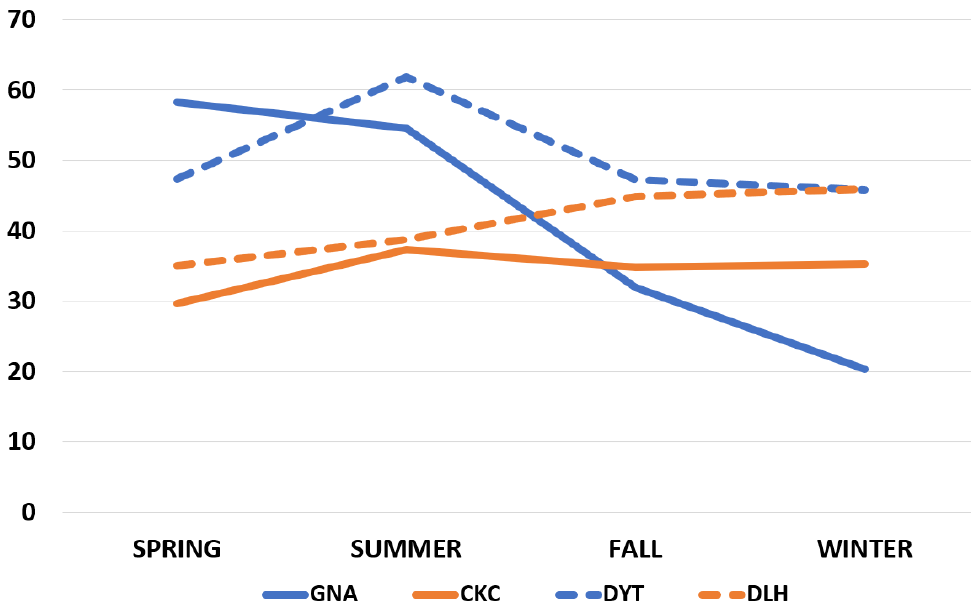
Figure 5. Percent of cold fronts associated with warming after frontal passage. Blue lines are coastal and orange lines are inland. Bold lines (GNA/CKC) and dashed lines (DYT/DLH) each represent a coastal/inland comparison.